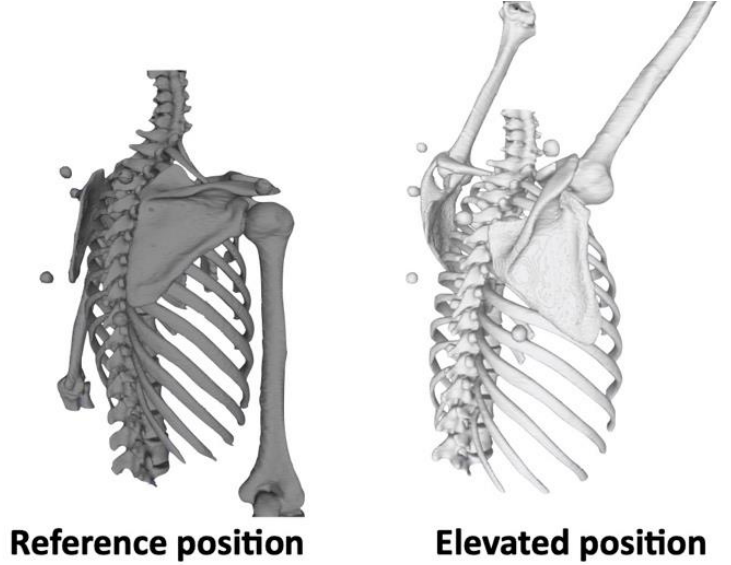
Figure 4. Three-dimensional surface models in the reference position (gray) and elevated position (white).